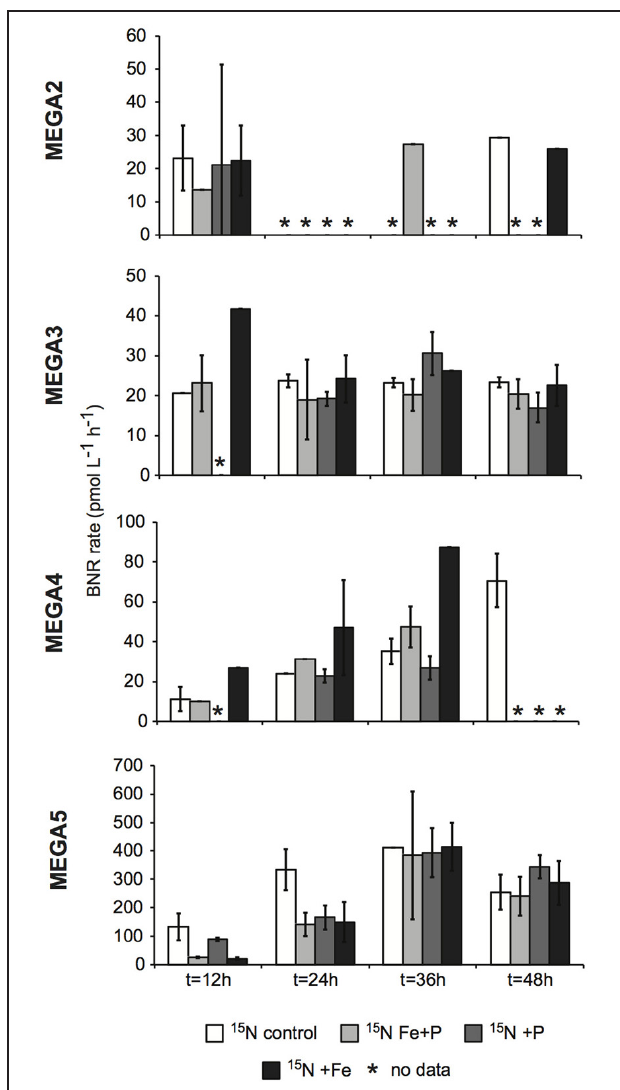
FIGURE 6 | Biological N 2 fixation rates associated with the < 10 µ m size-fraction in response to nutrient additions in the MEGA experiments. BNF rates were measured using the 15 N 2 tracer method. Error bars indicate the standard deviation for two replicates, where possible. Missing data is marked with an asterisk ( ∗ ). Note the different scales used for the y-axis.